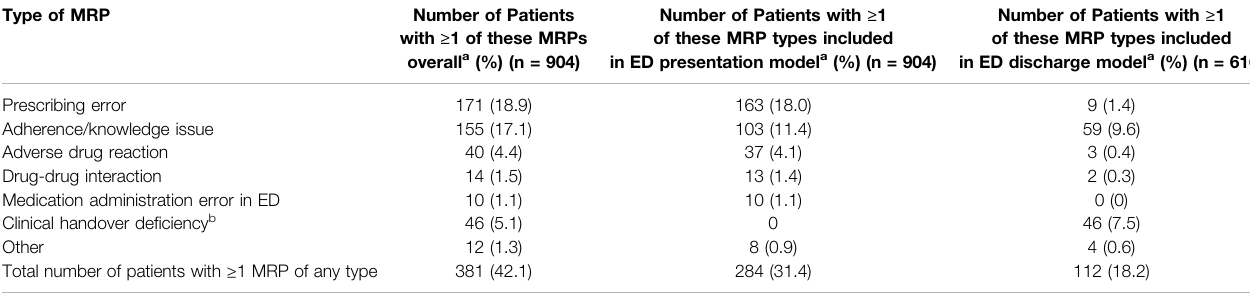
TABLE 1 | Types of medication-related problems included in the ED presentation and ED discharge models. Type of MRP Number of Patients with ≥ 1 of these MRPs